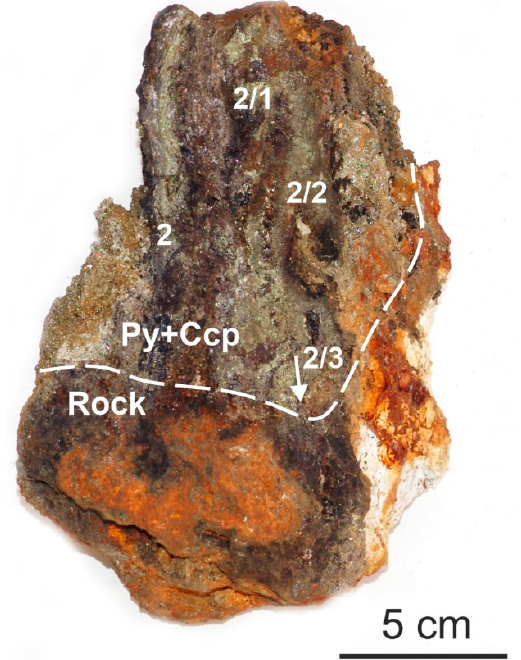
Figure 7. A general view of sample 242 ‐ 2 composed of pyrite, chalcopyrite and altered rock. The chalcopyrite ‐ pyrite layer has a structure quite similar to the 242 ‐ 1 sample de ‐ scribed above. Moreover, there is also isocubanite with a chalcopyrite exsolution (Figure 8a).